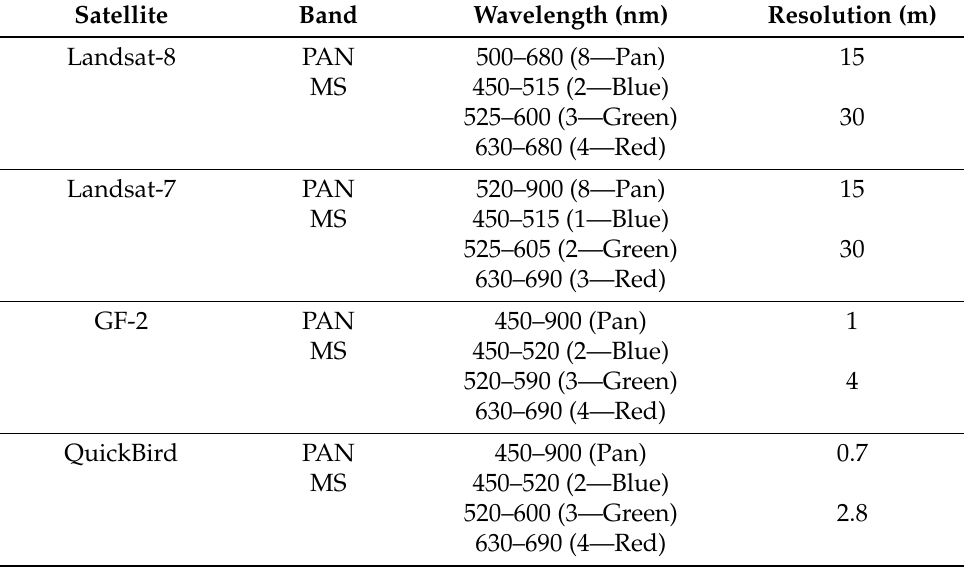
Table 1. Satellite